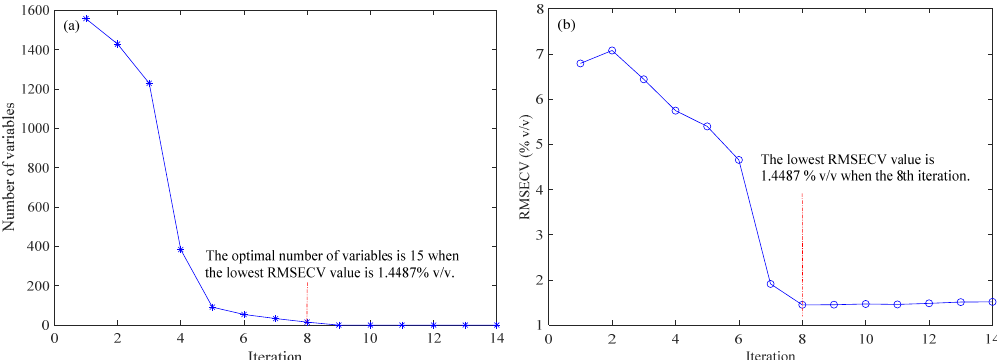
Figure 1. Evolution of the number of variables ( a ) and root-mean-square error of cross validation (RMSECV) ( b ) in each iteration of the sub-models using the bootstrapping soft shrinkage (BOSS) algorithm.